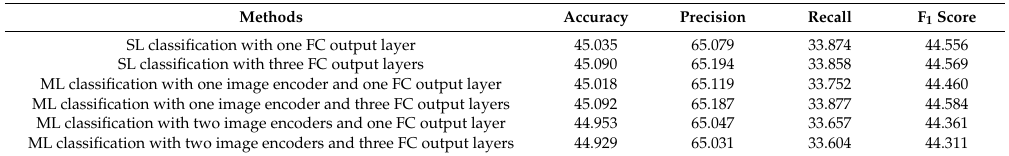
Table 11. Indirect comparative analysis of conventional methods. The same dataset is used for